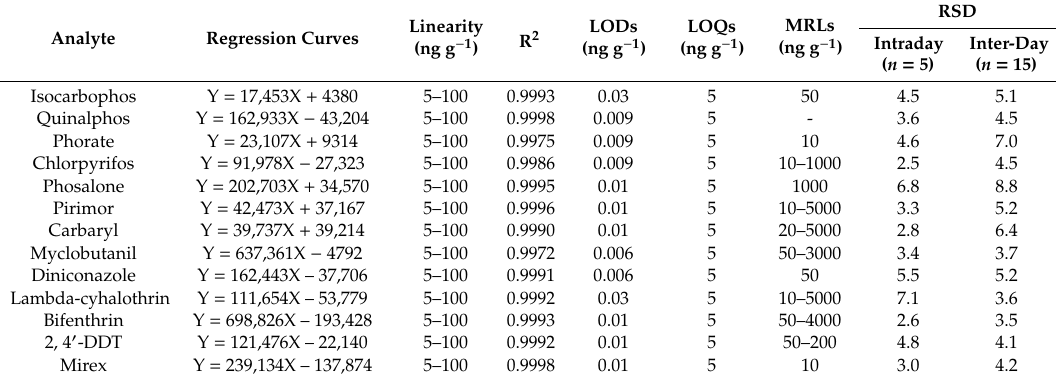
Table 1. The linearity, determination coe ffi cients, LOD, LOQ, and RSD for insecticides in the tomato